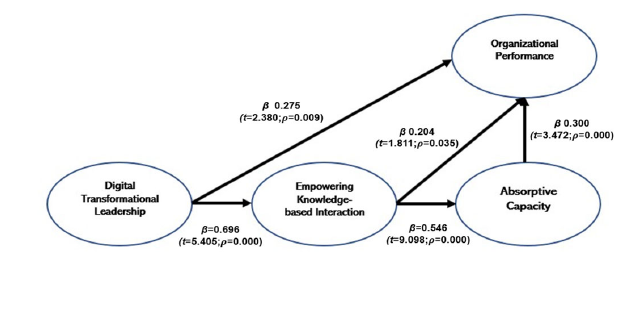
Fig. 4. Empirical Model